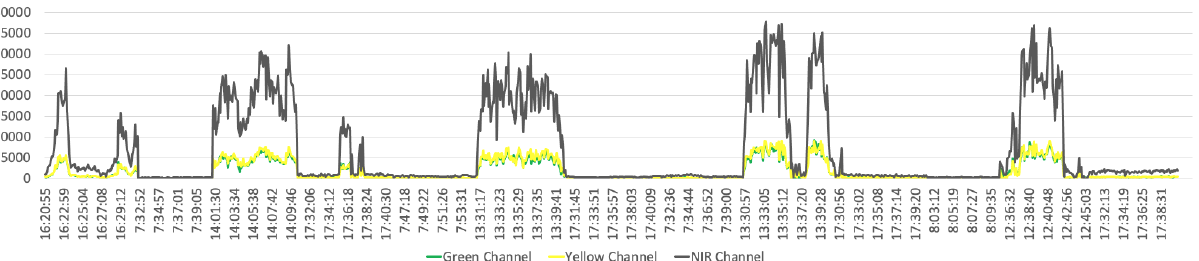
Figure 11. Aerial green, yellow, and NIR channel data compared with corresponding ground-based channel data.